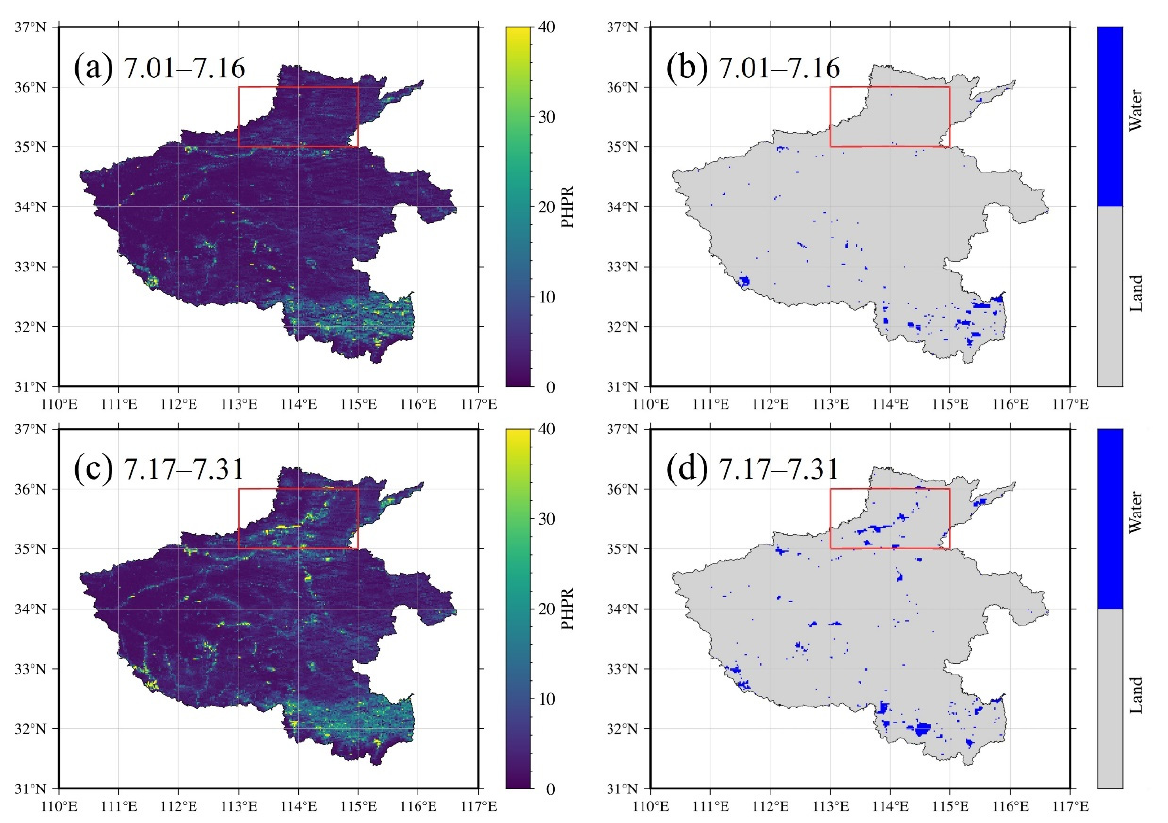
Figure 14. PHPR map ( a ) and PHPR water mask ( b ) of Henan before the rainfall (1 July 2021 to 16 July 2021). PHPR map ( c ) and PHPR water mask ( d ) of Henan after the rainfall (17 July 2021 to 31 July 2021). Red rectangle in each plot represents the flooding area in